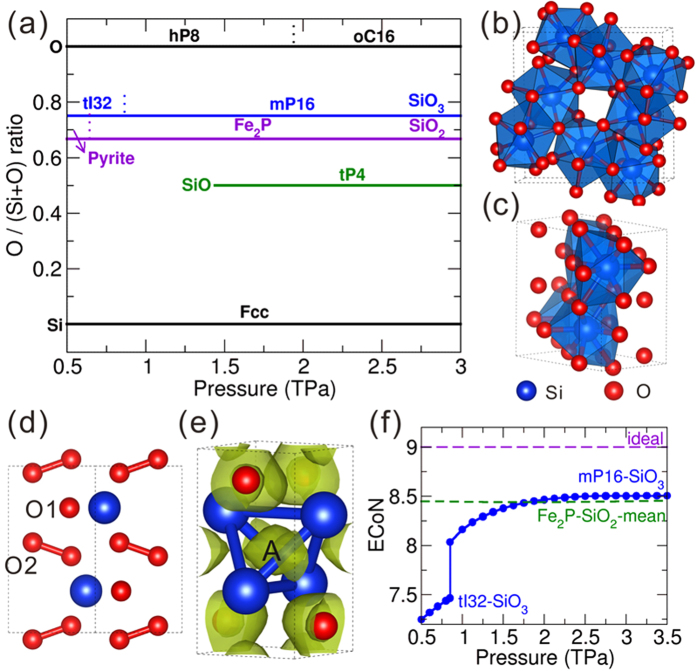
(a) Pressure-composition phase diagram of the Si-O system. Crystal structures of (b) tI32-SiO3 and (c,d) mP16-SiO3. O1 and O2 refer to two types of O atoms in mP16-SiO3. (e) Crystal structure of tP4-SiO and isosurface of the electron localization function (ELF) with an isovalue of 0.65. Letter A refers to the strong interstitial electronic attractor in the Si4 tetrahedron. (f) ECoN for tI32-SiO3 and mP16-SiO3 as a function of pressure. The mean ECoN value for Fe2P-SiO2 is shown by a green dashed line, and the ideal CoN of 9 is given by a purple dashed line. The densities of states of tI32-SiO3, mP16-SiO3, and tP4-SiO show that they are insulators at 0 K, see Supplementary Materials.